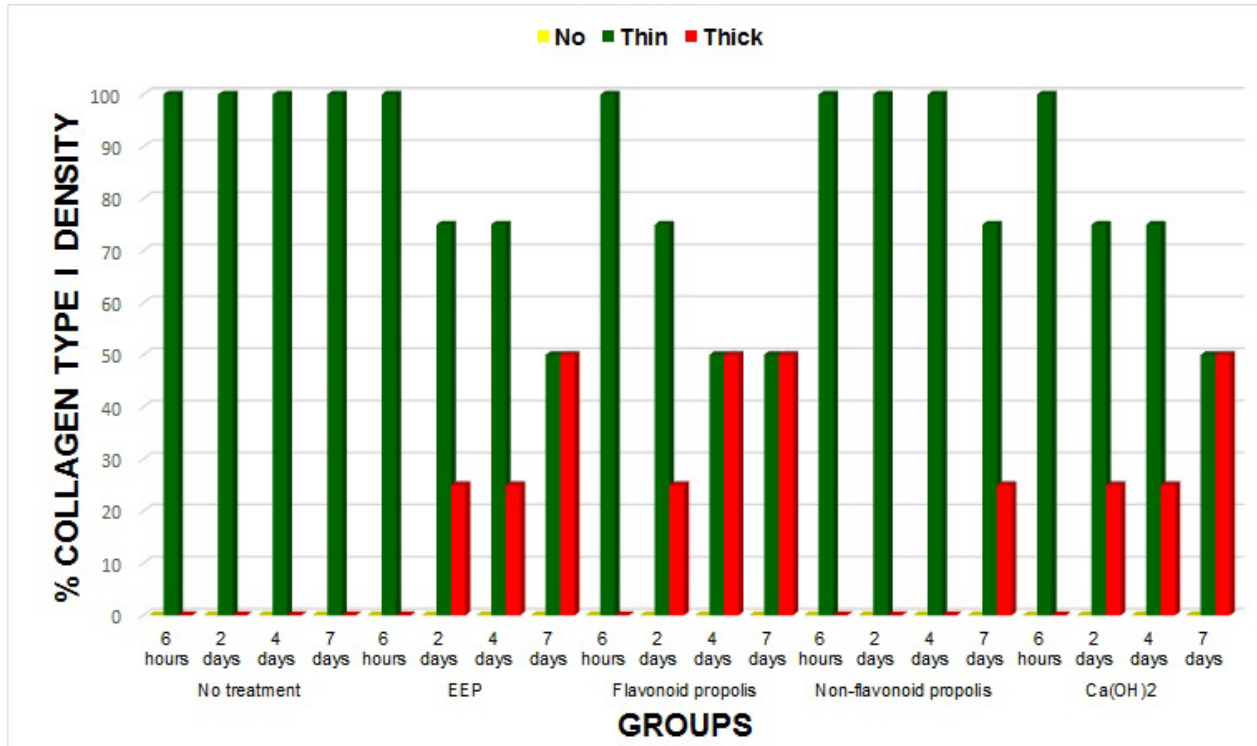
Fig. 1 - Histogram of percentage of collagen type I density on rats dental pulp tissue of all groups after 6 hours, 2 days, 4 days and 7 days of materials test Table 1 - The difference of collagen type I density among time periods for each group. Groups